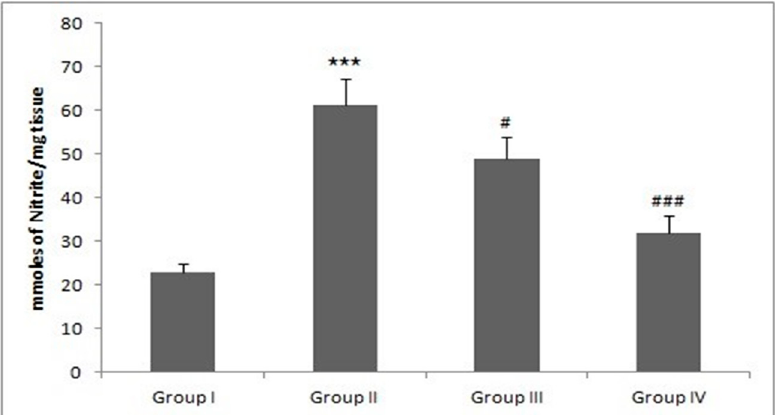
Figure 8. Effect of piperine and DMH-administered group on nitrite levels. In DMH administered group-II, the nitrite levels were significantly increased ( *** p < 0.001) as compared to control group-I. Treatment with piperine significantly (30 and 60 mg/kg b. wt.) attenuated nitrite levels in group III ( # p < 0.05) and group IV ( ### p < 0.001) as compared to group-II ( n = 10).